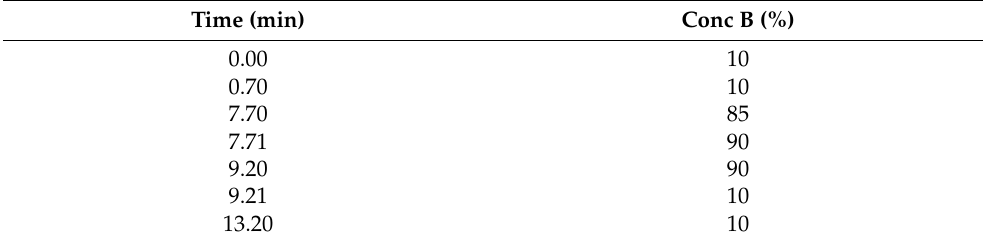
Table 2. Elution